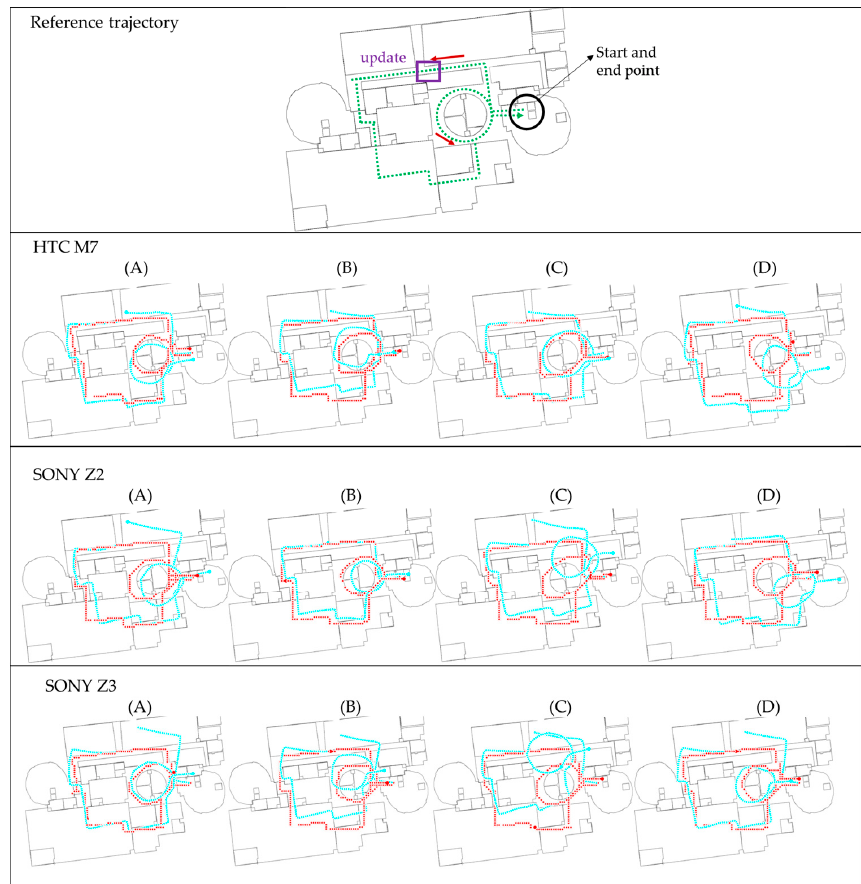
Figure 13. The experimental trajectories at III office floor.